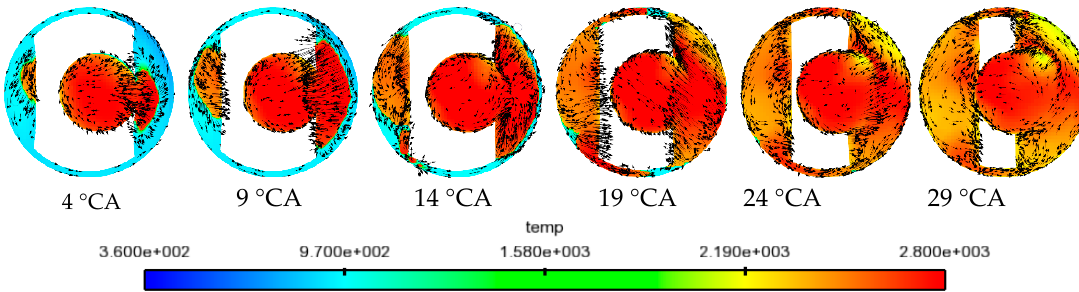
Figure 13. Temperature cloud and instantaneous velocity field (top view).